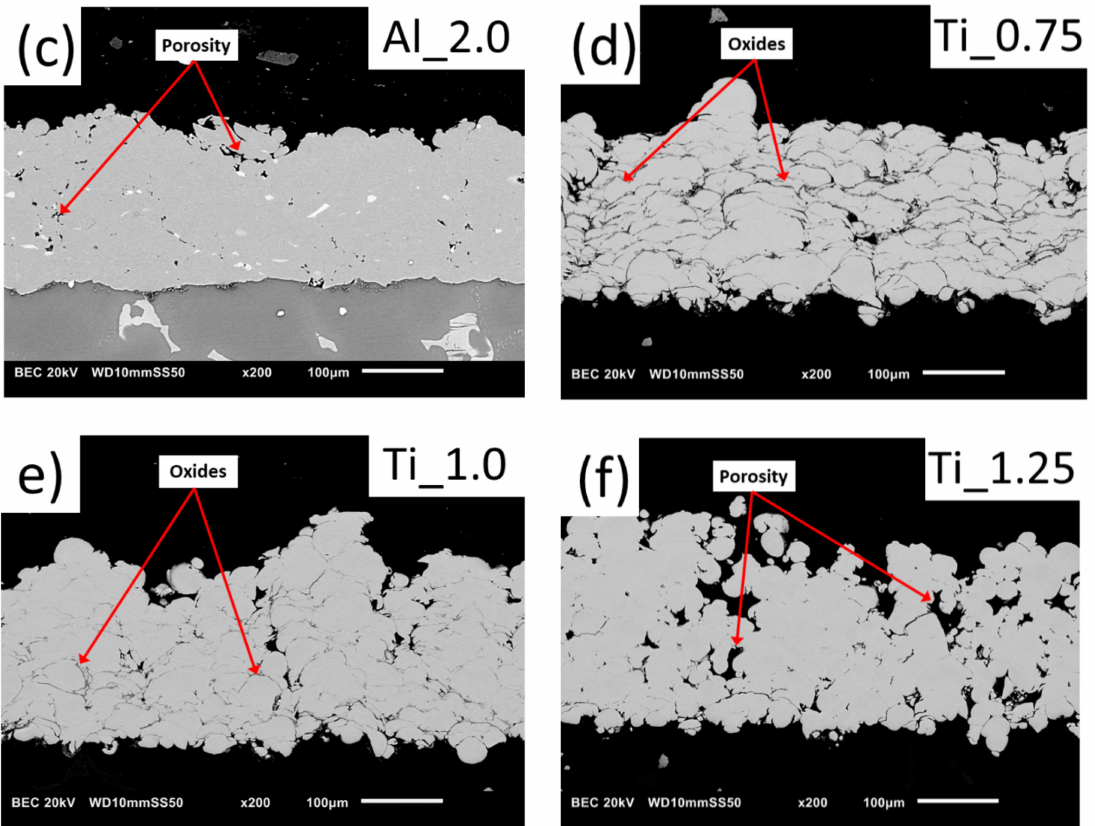
Figure 4. SEM images of cross-sections of WS coatings: ( a ) Al_1.0, ( b ) Al_1.5, ( c ) Al_2.0, ( d ) Ti_0.75, ( e ) Ti_1.0, and ( f ) Ti_1.25.